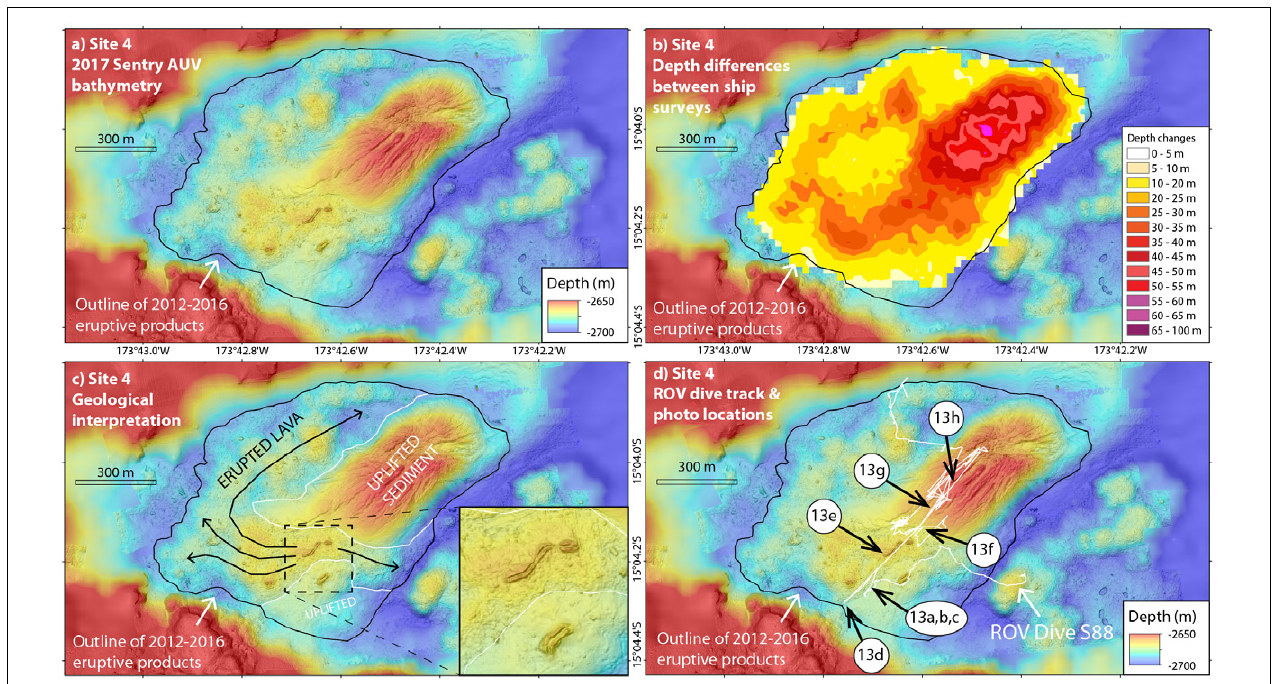
FIGURE 12 | Maps of eruption site #4, at the NE base of West Mata (see Figure 2 ) showing (a) post-eruption Sentry AUV bathymetry from 2017, (b) positive depth differences between ship-based surveys in 2012 and 2016 ( Table 2 ), (c) geological interpretation on 2017 AUV bathymetry, and (d) trackline of SuBastian ROV dive S88 (white line) on Sentry AUV bathymetry, with locations of images in Figure 13 (white numbered circles). In (d) note that the navigation for this dive was considerably noisier than for others on this expedition due to problems with the acoustic tracking system on R/V Falkor . Black outlines enclose the site #4 eruption deposits; white outlines in (c) delineate uplifted sediments and inset shows detail of tumuli structures in young lava